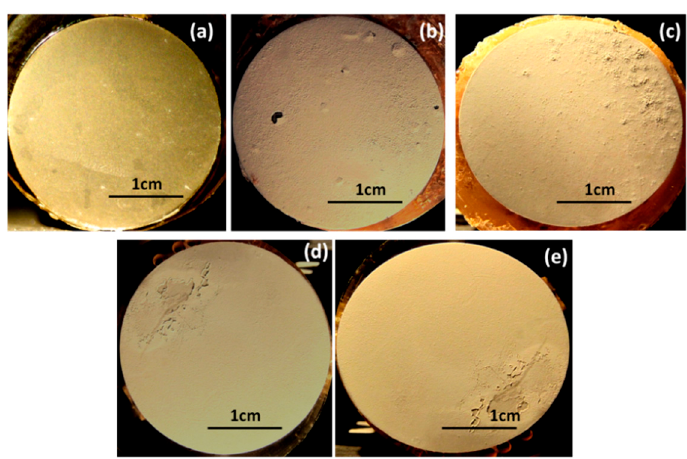
Figure 10. The specimens after 7 days of immersion in a solution of 0.1 M NaCl: ( a ) bare aluminum surface; ( b ) coated sample at 60 °C–24 h; ( c ) 80 °C–18 h; ( d ) 80 °C–24 h; and ( e ) 100 °C–18 h.